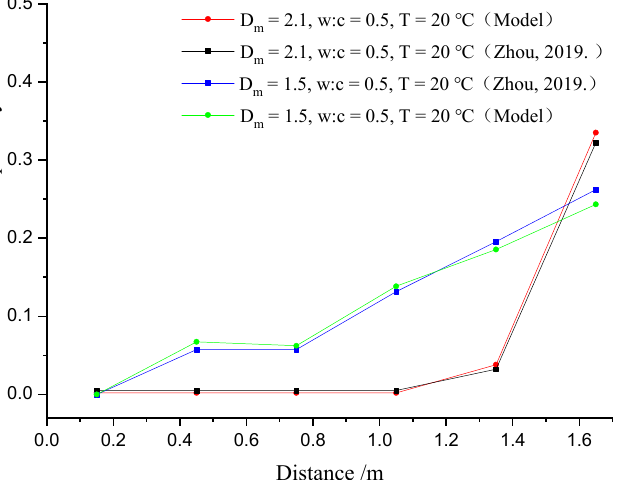
Figure 1. Variation in porosity of porous media with distance for each test point in different mass fractal dimensions in experiments and models.